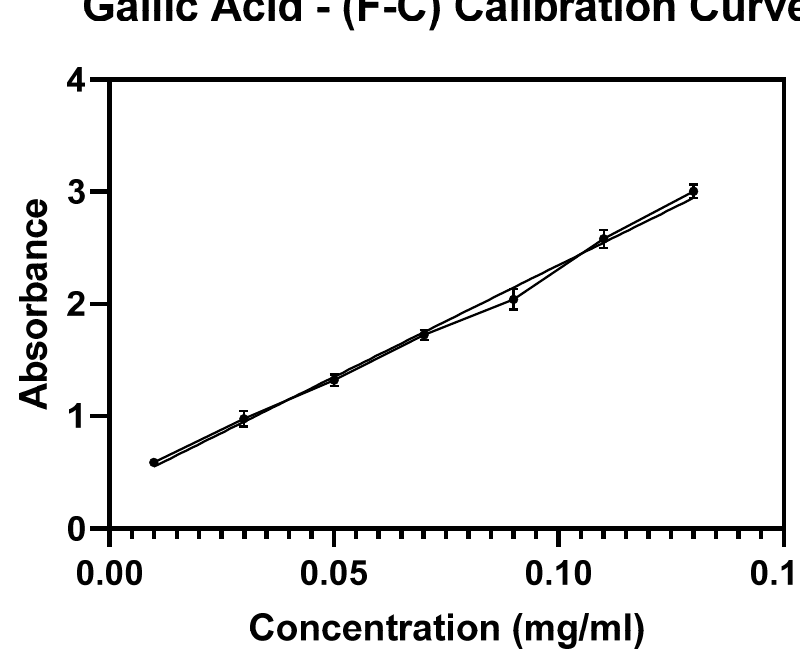
Figure A1. Calibration curve of GA applying F–C assay.